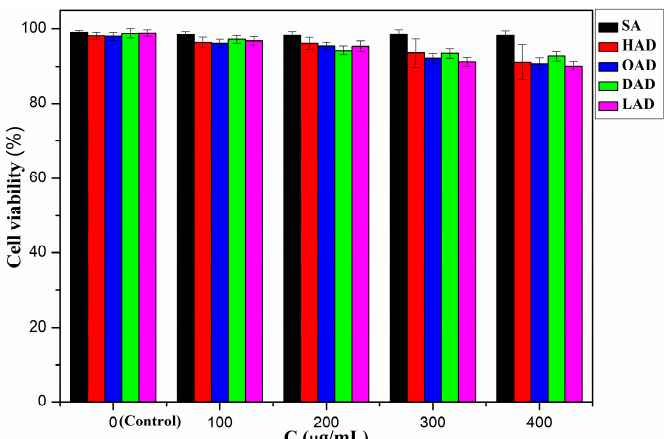
Figure 10. CCK-8 assay for cytotoxicity of RAW 264.7 cells cultured on SA, HAD, OAD, DAD, and LAD after 2 days